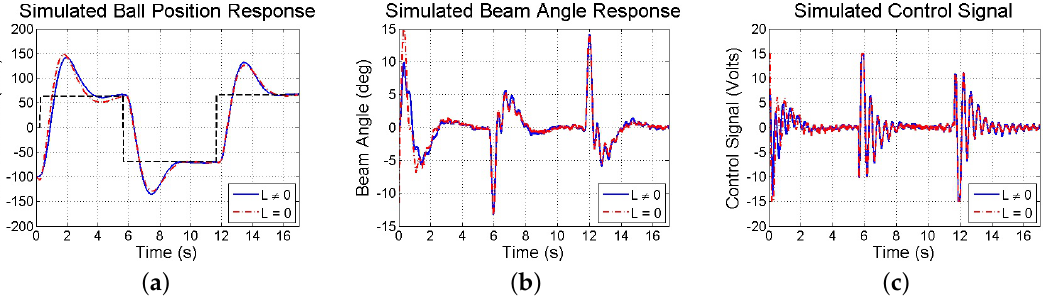
Figure 17. Simulated response of ( a ) ball position; ( b ) beam angle; and ( c ) control computed to step commands using two methods to estimate ˆ x p